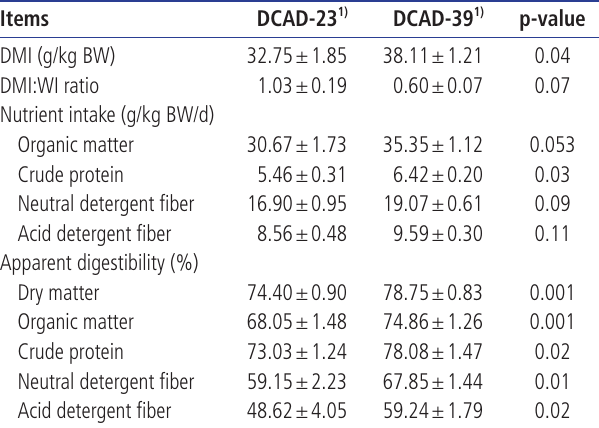
Table 2. Effects of dietary cation and anion difference on dry matter intake, the ratio of dry matter intake and water intake, nutrient intake and apparent digestibility at 8th weeks postpartum in dairy